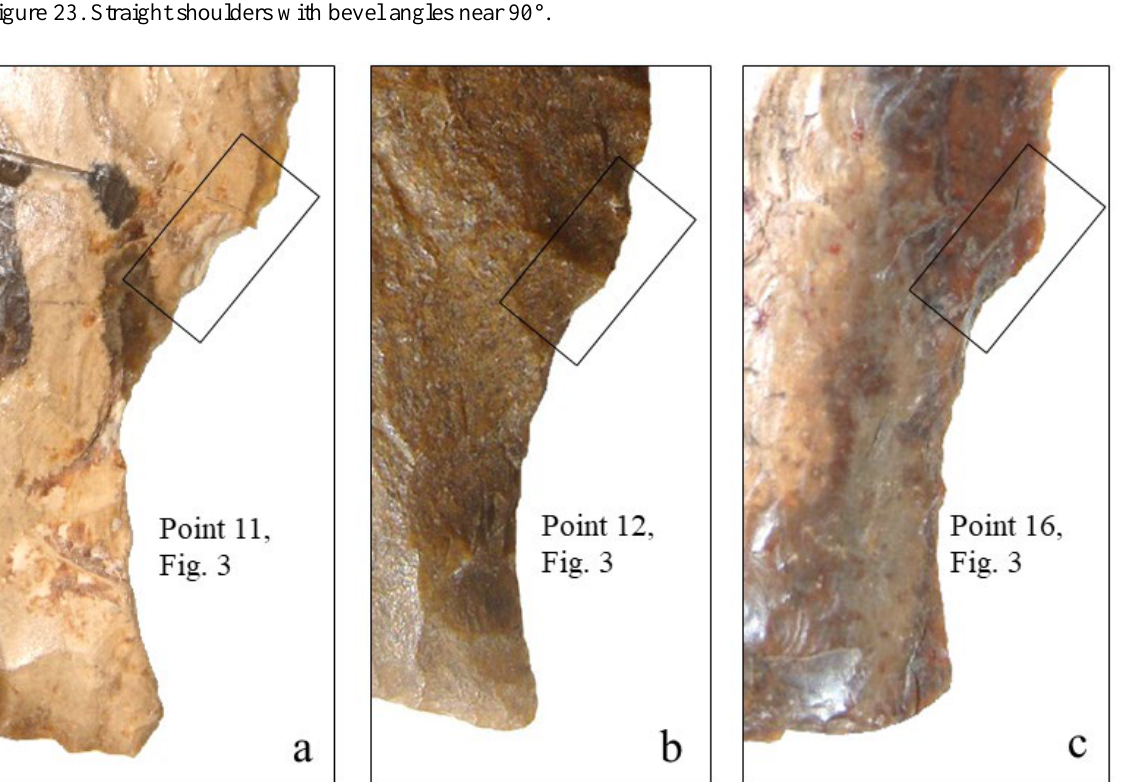
Figure 24. Rounded shoulders with similar edge angles integrated to the edges of the blades in classic